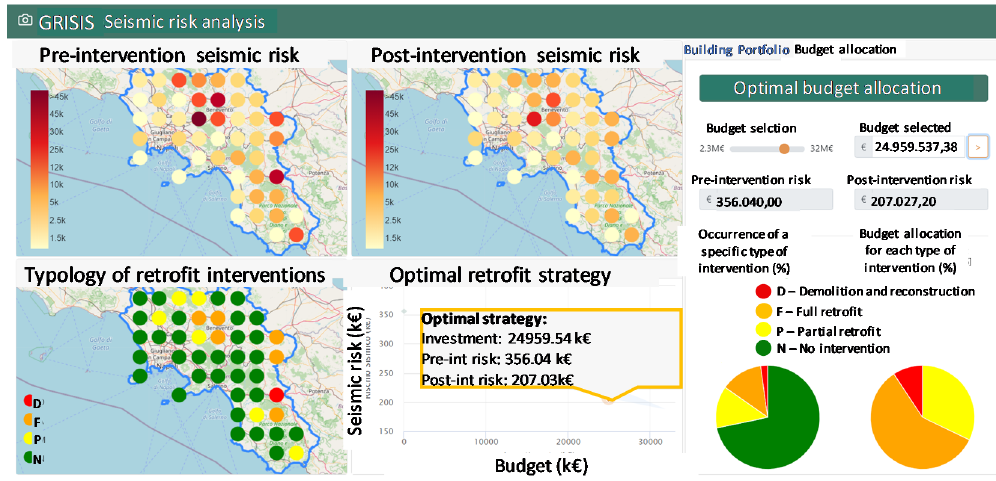
Figure 9. Optimal budget allocation for an investment of 2.5 × 10 7 € .